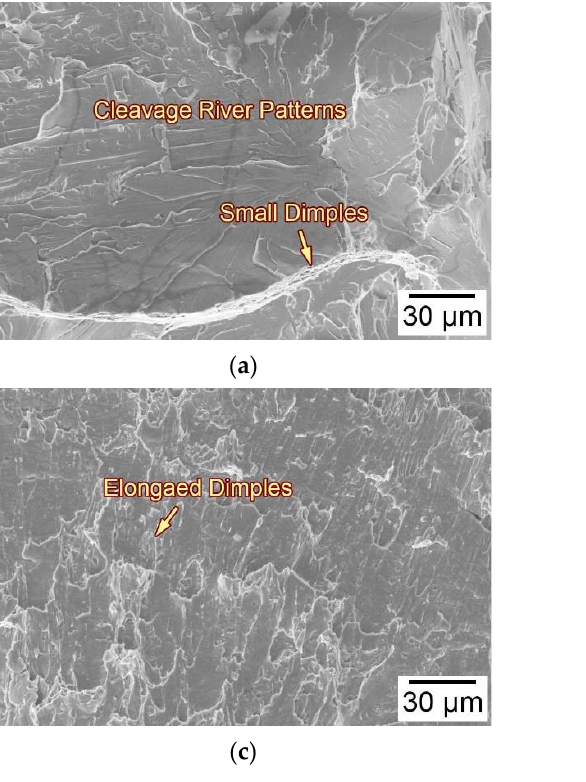
Figure 7. SEM-SE images showing the fracture surfaces of the ( a , b ) radical zone and ( c , d ) the shear lip zone in ( a , c ) 11Ca-1 and ( b , d ) 11Ca-2 steels after large-heat-input welding at 400 kJ cm − 1 .